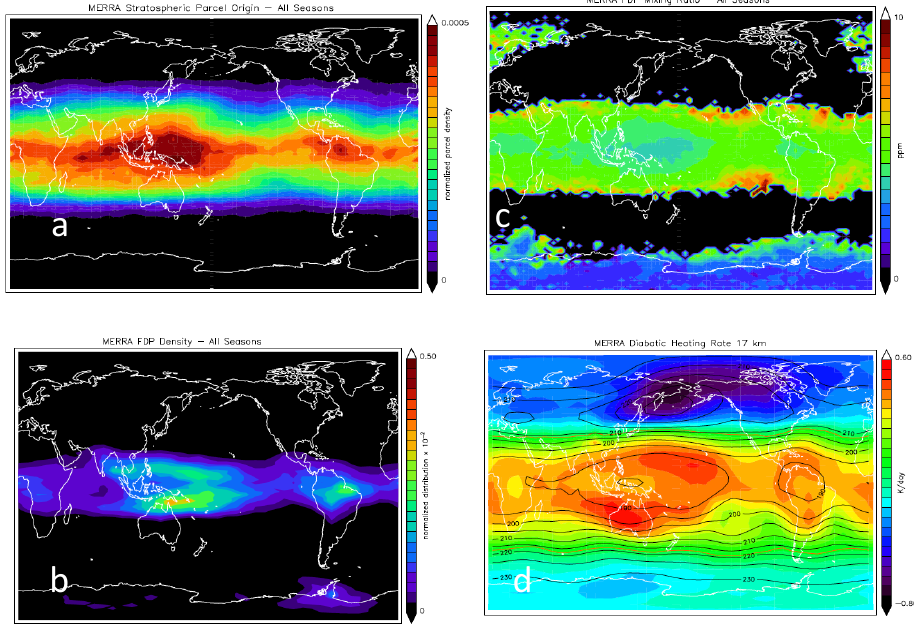
Fig. 7. Statistical results for parcels that end up in the stratosphere. (a) , Density of origin points at the 360K level. (b) , density of final dehydration locations. (c) , the average mixing ratio at the final dehydration point in ppm. (d) , annual average heating rate at 17km in Kday − 1 (as in Fig.